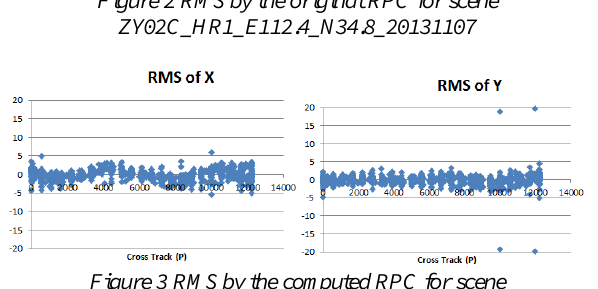
Figure 3 RMS by the computed RPC for scene